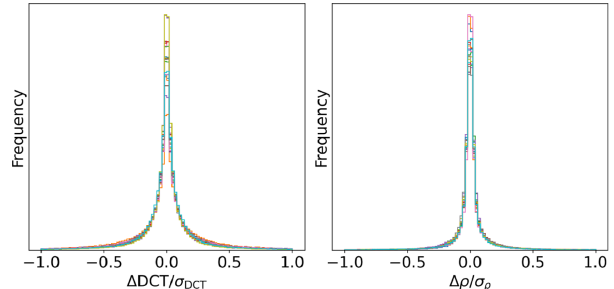
FIG. 9. Residuals of the fit to the phase space density using the trained neural network. Left: histograms showing the frequency of different values of Δ DCT = σ , where Δ DCT is the difference DCT between the known DCT values (in one case from the test data) and the values found by the neural network from the correspond- ing sinograms, and σ is the standard deviation of the DCT DCT values. Right: histograms showing the same residual analysis, but using the phase space densities, rather than the DCT of the densities. About 20 cases are superposed in each plot: there is little variation between the cases in the distributions of